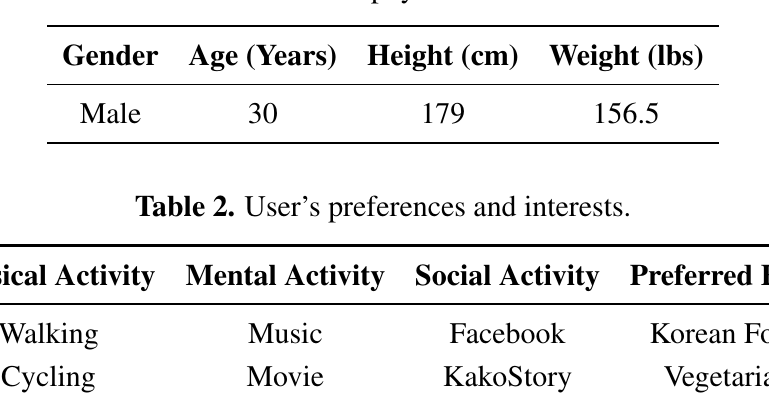
Table 1. User’s physical statistics.